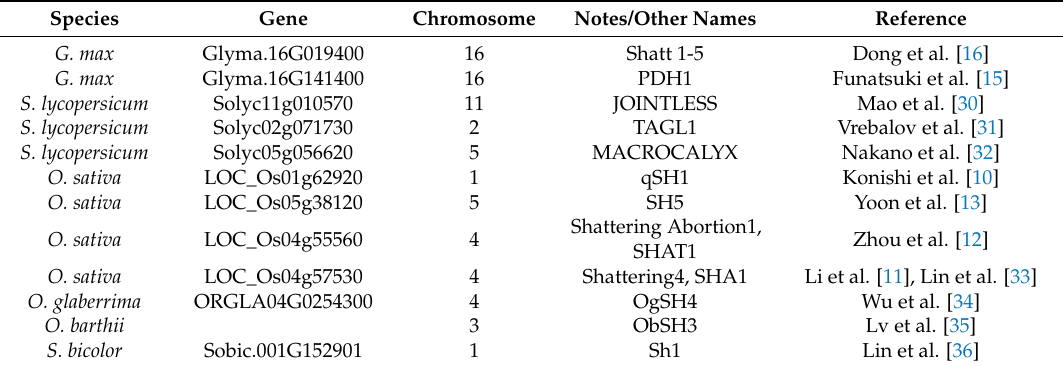
Figure 8. Role of Indehiscent in correct differentiation and lignification of the dehiscence zone. ( A - C ) Representative scanning electron microscopy of dehiscence zone in mature fruit of wild-type A. thaliana ( A ) and in two A. thaliana indehiscent mutants for ind-2 ( B ) and ind-1 ( C ). The ind-2 mutant lacks correct differentiation of valve margins. sl, separation layer; r, replum; v, valves. ( D – F ) Representative transverse sections of the mature fruit of wild-type A. thaliana ( D ) and in the two A. thaliana indehiscent mutants for ind-2 ( E ) and ind-1 ( F ), with lignin-specific staining with